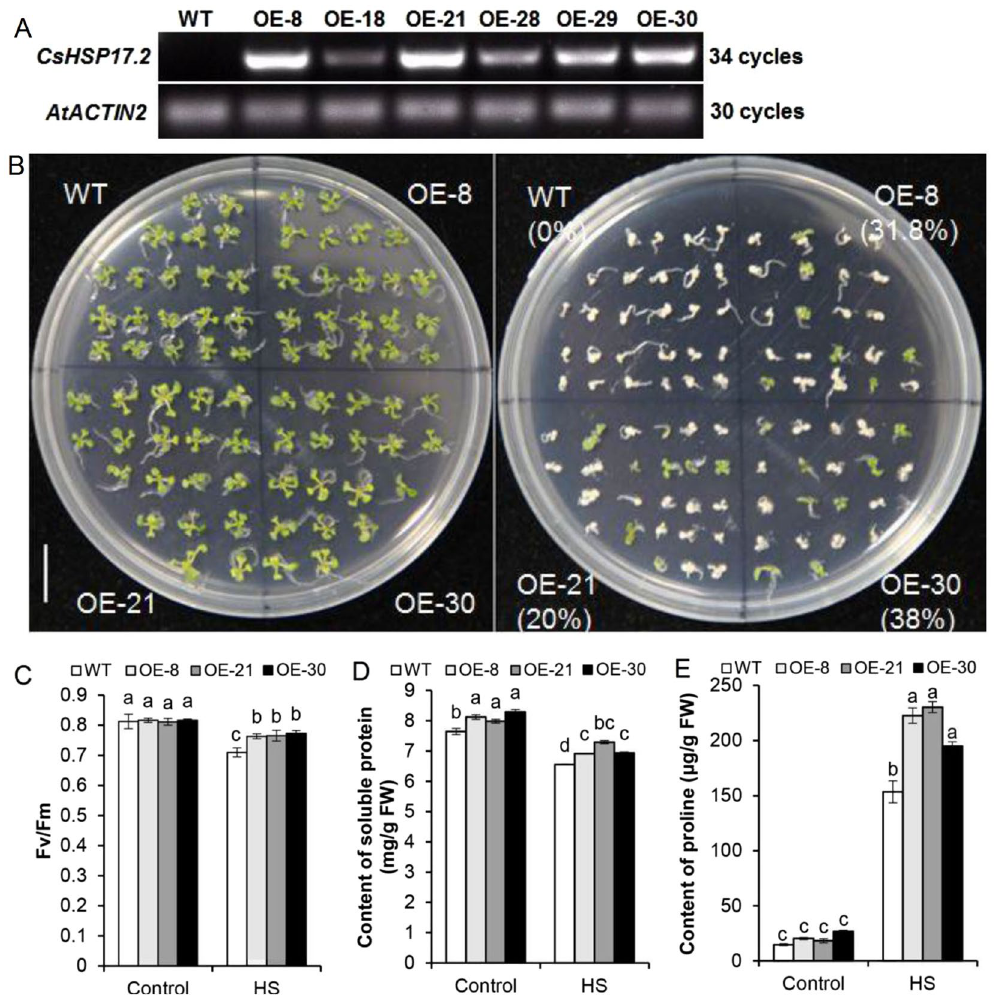
Figure 6. Thermotolerance of WT and transgenic A. thaliana . ( A ) RT-PCR identification of CsHSP17.2 transgenic A. thaliana lines. Total RNA was extracted from rosette leaves of 4-week-old plants, and the AtACTIN2 (AT3G18780) gene was used as a control for equal loading. ( B ) The survival rates of WT and transgenic A. thaliana plants under HS. The detection of chlorophyll fluorescence ( C ), soluble protein content ( D ) and proline content ( E ) in transgenic and WT plants. The A. thaliana seedlings were cultivated for four weeks under normal temperature (22 °C; Control) before HS (45 °C for 4 h), and the rosette leaves were harvested for the experiments. Data represent the means ± standard deviations of three replicates. Significant differences between WT and transgenic plants are indicated by different letters ( P < 0.05). WT: wild-type; OE-8, OE-18, OE-21, OE-28, OE-29, and OE-30: six transgenic A. thaliana